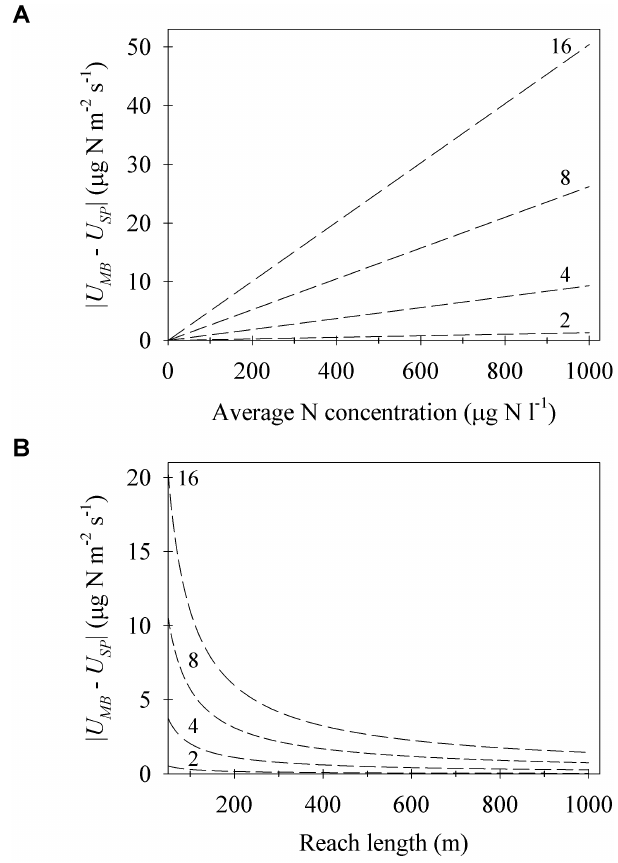
Fig. 4. Box plots summarizing the confidence intervals (CI) cal- culated for the net uptake rates using the mass balance approach ( U MB ) and the spiraling approach ( U SP ) for (A) NO 3 and (B) NH 4 . Data are from Santa Fe ( n = 25) and Fuirosos ( n = 20) streams. The centre horizontal line in each plot is the median value. Fifty percent of the data points lie within each box. The whiskers above and below the box indicate the 90% and 10% percentiles. Circles are outliers. See text for details on the calculation of the CI for each